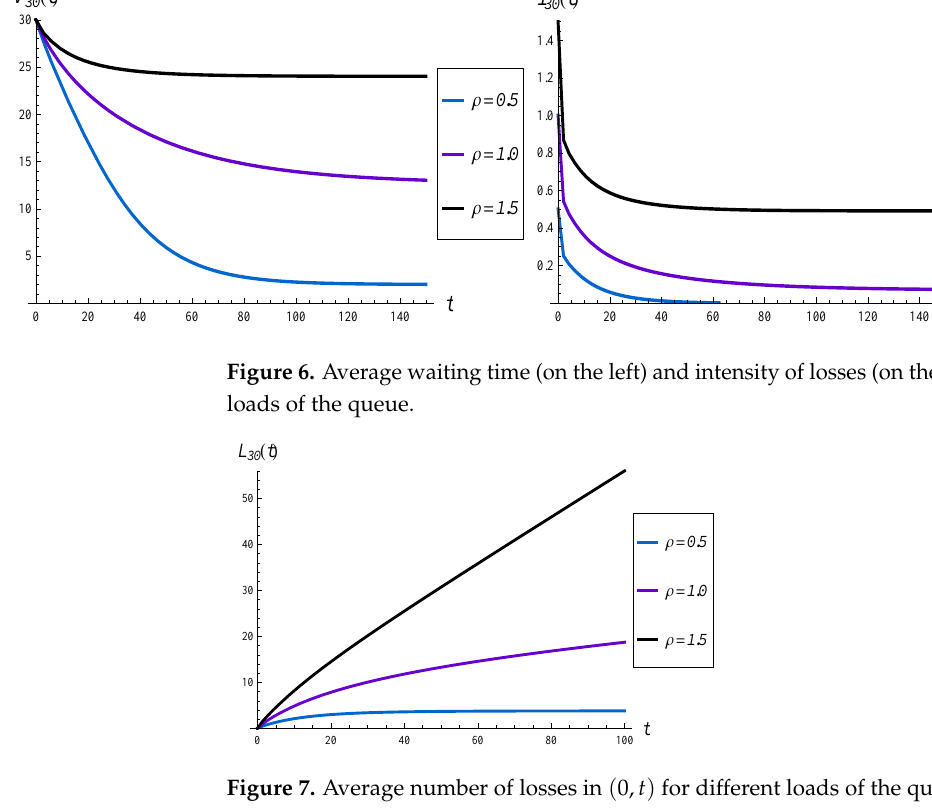
Figure 7. Average number of losses in ( 0, t ) for different loads of the